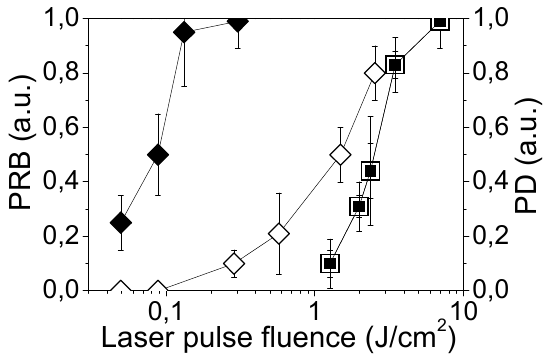
Figure 10. Influence of the fluence of a single pump laser pulse (532 nm, 0.5 ns) on the